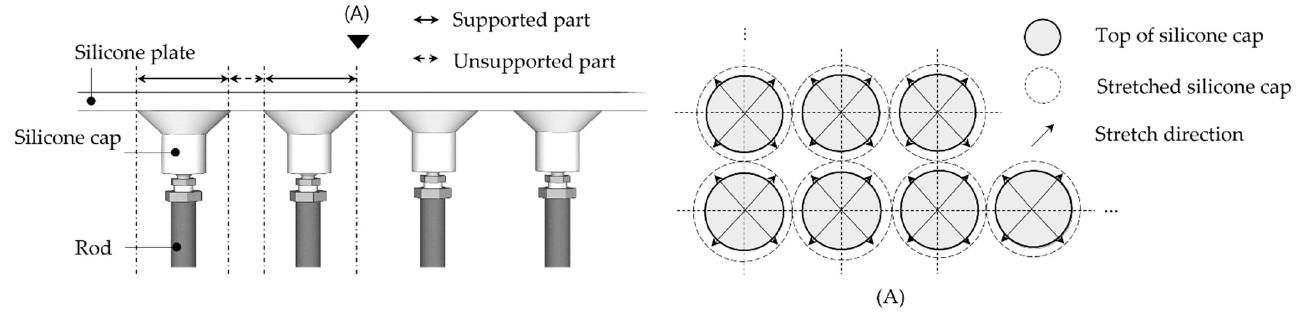
Figure 6. Concrete load bearing in silicone cap.